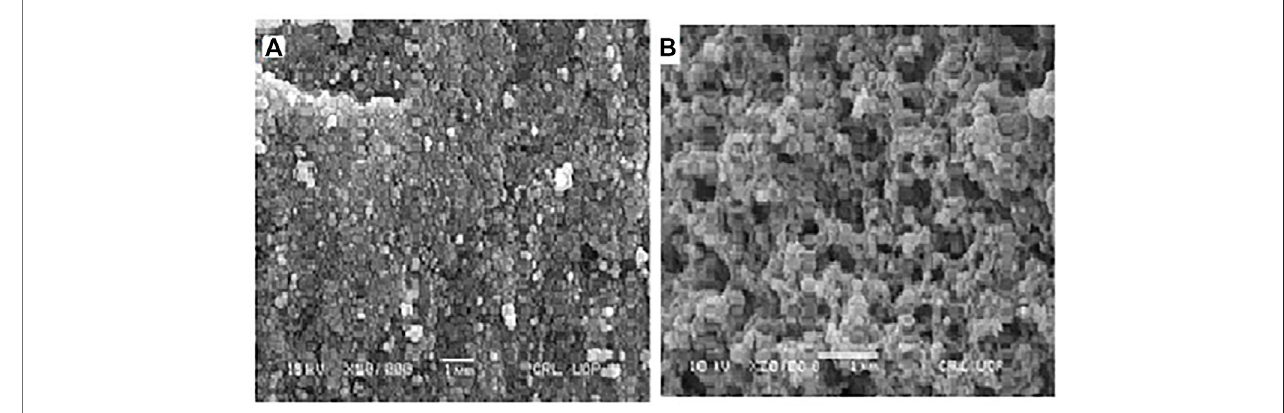
FIGURE 3 | SEM image of (A) MNP and (B) MC.